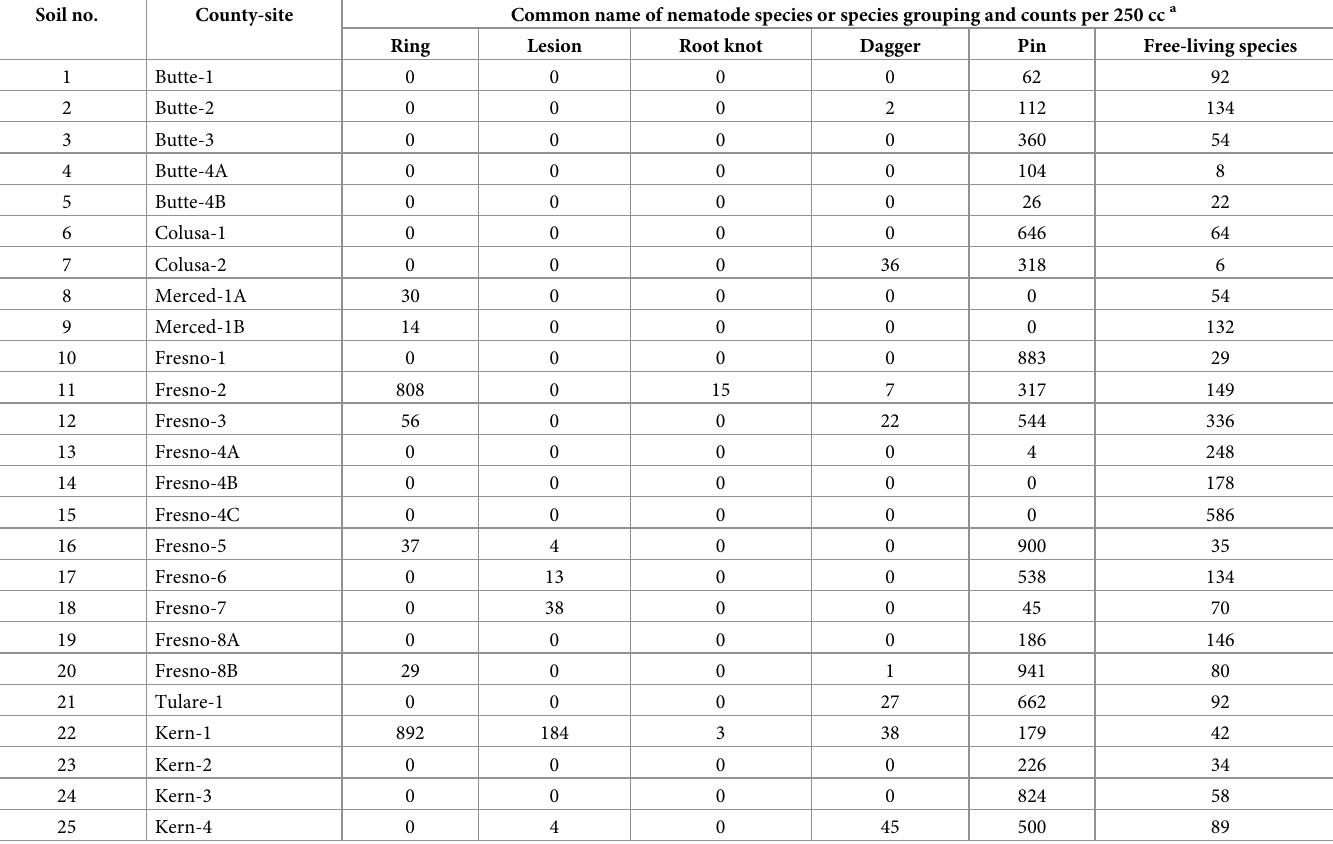
a “Ring” indicates Mesocricinema xenoplax ; “Lesion” indicates Pratylechus sp.; “Root knot” indicates Meloidogyne incognita ; “Pin” indicates Paratylenchus sp. All nematodes were extracted by centrifugal flotation and identified by morphological